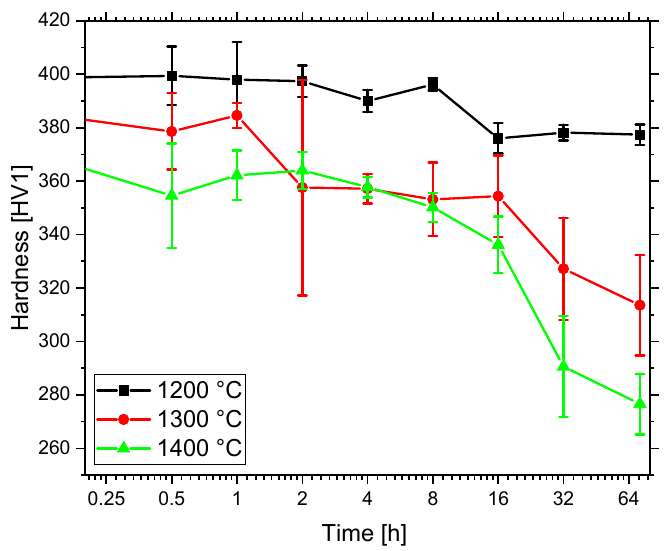
Figure 7. Evolution of hardness [HV1] in time for 1200, 1300 and 1400 °C.